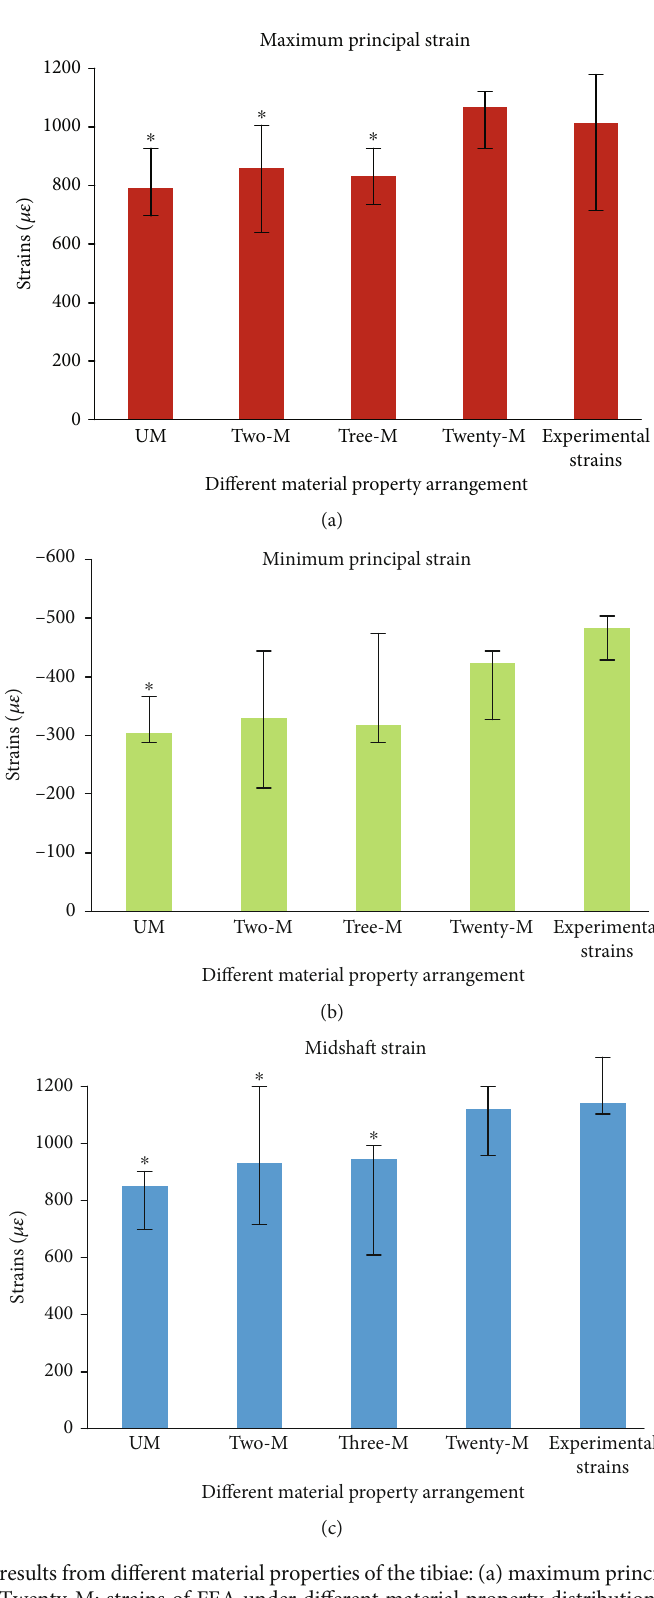
Figure 12: Comparisons of FEA results from di ff erent material properties of the tibiae: (a) maximum principal strain; (b) minimum principal strain; (c) midshaft strain; UM ~ Twenty-M: strains of FEA under di ff erent material property distribution. ∗ Signi fi cantly di ff erent from the experimental results from ANOVA followed by LSD; P < 0 : 05